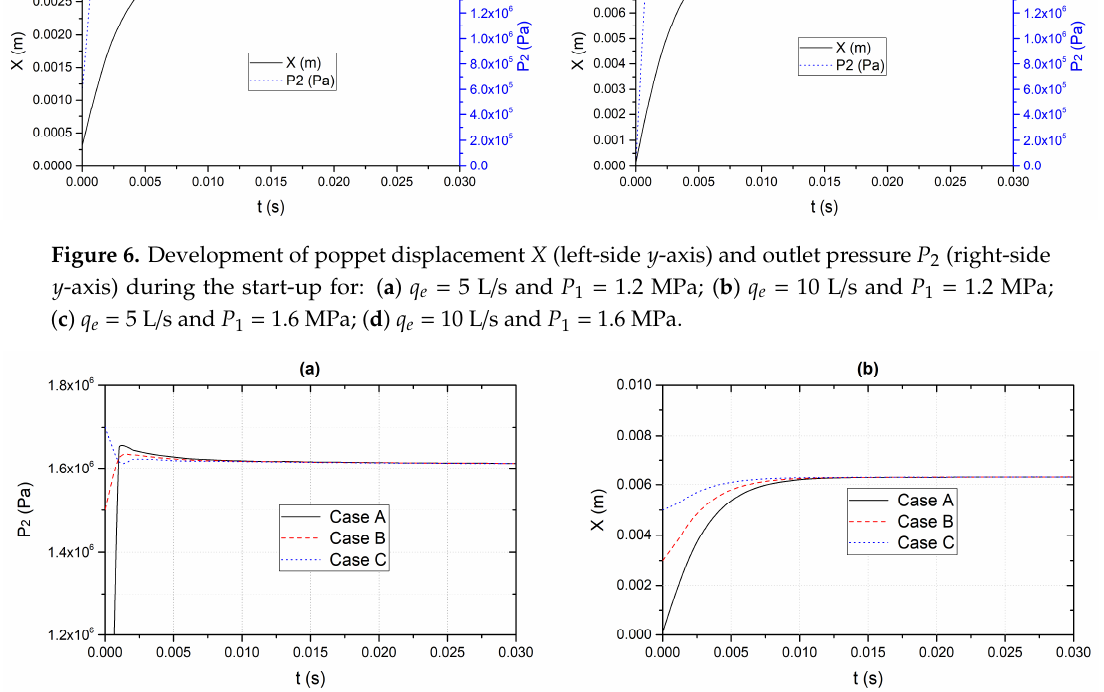
Figure 7. E ff ect of varying initial conditions (ICs) on the valve start-up characteristics under q e = 8 L / s and P 1 = 1.6 MPa: ( a ) Outlet pressure P 2 ; ( b ) poppet displacement X . ICs for Case A: P 2 ( 0 ) = 0 Pa and X ( 0 ) = 0 mm; ICs for Case B: P 2 ( 0 ) = 1.5 MPa and X ( 0 ) = 3 mm; ICs for Case C: P 2 ( 0 ) = 1.7 MPa and X ( 0 ) = 5 mm.